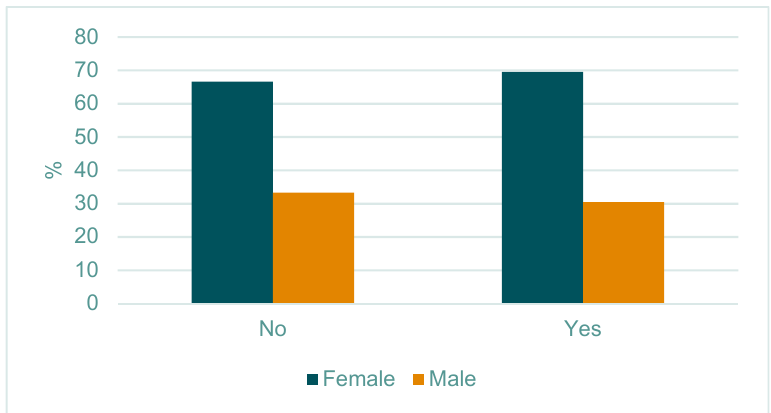
Figure 9. Response to the question “Based on your sensitivity to the presented maps, are you willing to make changes in your neighborhood?”, by sex.